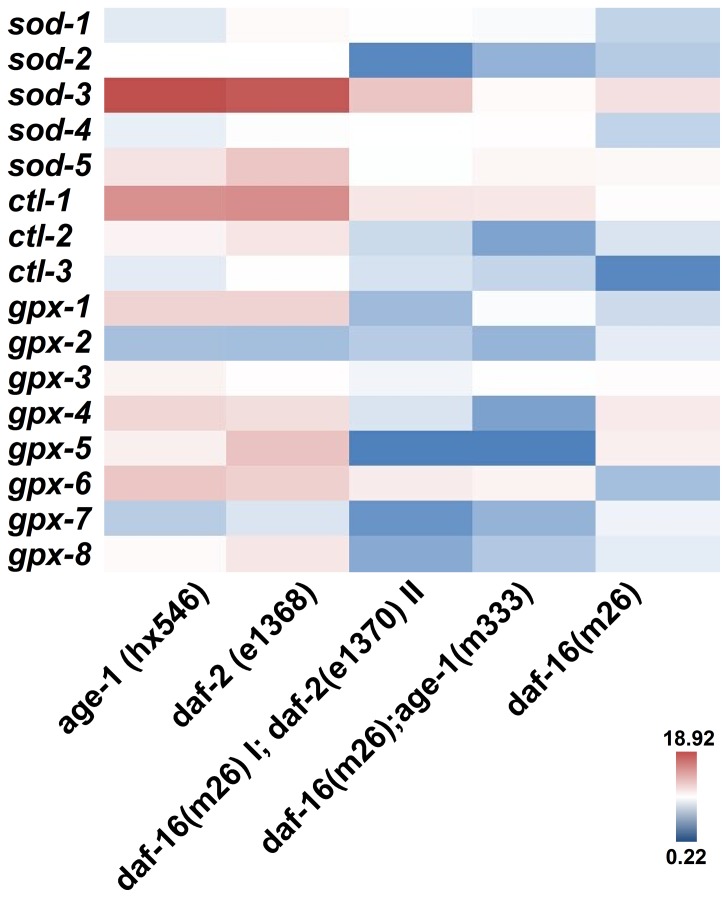
mRNA expression levels of antioxidant enzymes in daf-2, age-1, daf-2;daf-16, age-1;daf-16 and daf-16 mutants.Heat map analysis of the RNA expression patterns of daf-2 and age-1 versus N2. Both sod-3 and sod-5 expression levels were increased in daf-2 and age-1 mutants. Both ctl-1 and ctl-2 were increased in daf-2 and age-1 mutants. gpx-3,4,5,6,7,8 were increased in daf-2 and age-1 mutants. There were no significant difference between N2 and daf-16 mutant except for sod-3 and gpx-4. The red is high; the blue is low.